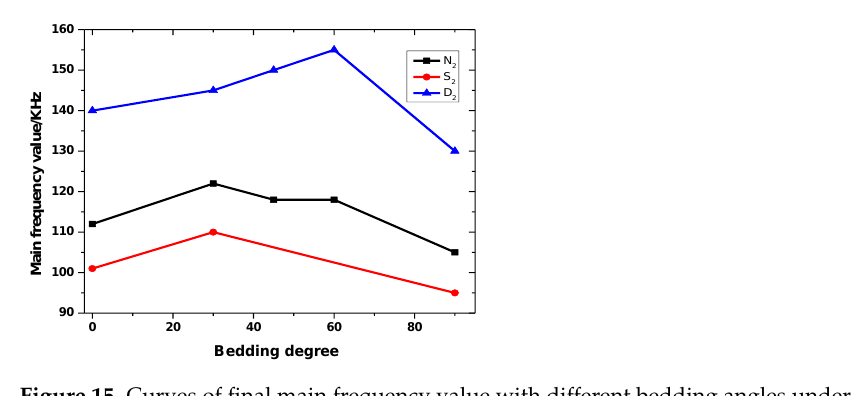
Figure 15. Curves of final main frequency value with different bedding angles under different water content levels.